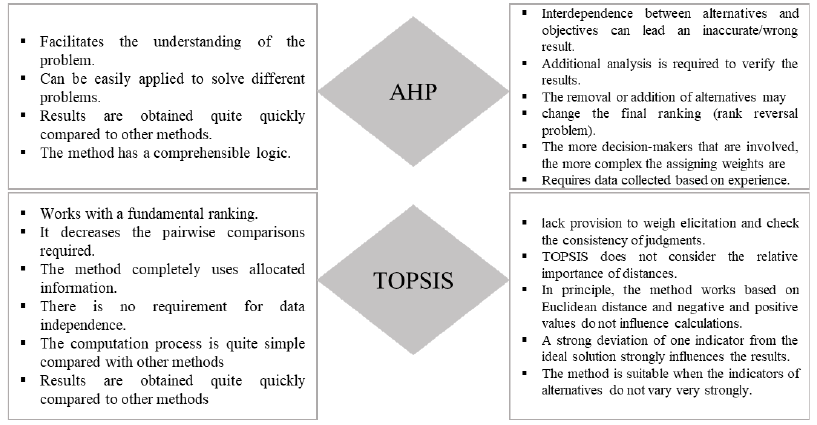
Figure 2. Advantages and disadvantages of existing MCDM methods.